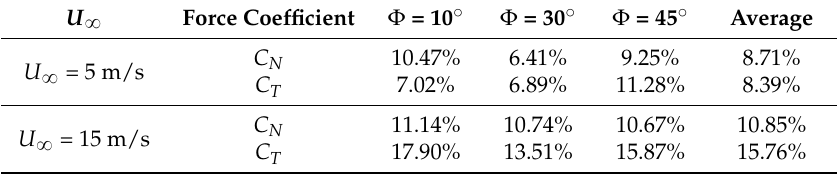
Table 5. The percentage number of data points across the entire rotor disc failing the Shapiro–Wilk’s test.